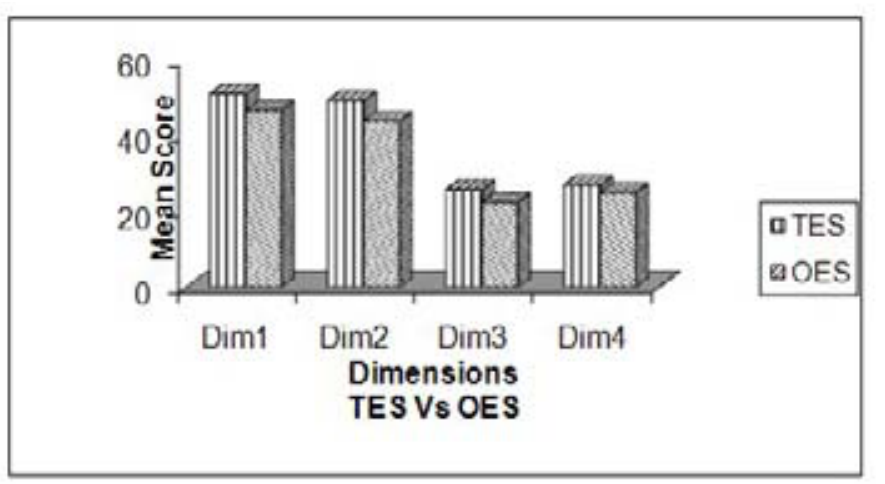
Figure 3 . Dimension-wise comparison of mean values for academic motivation of TES and OES